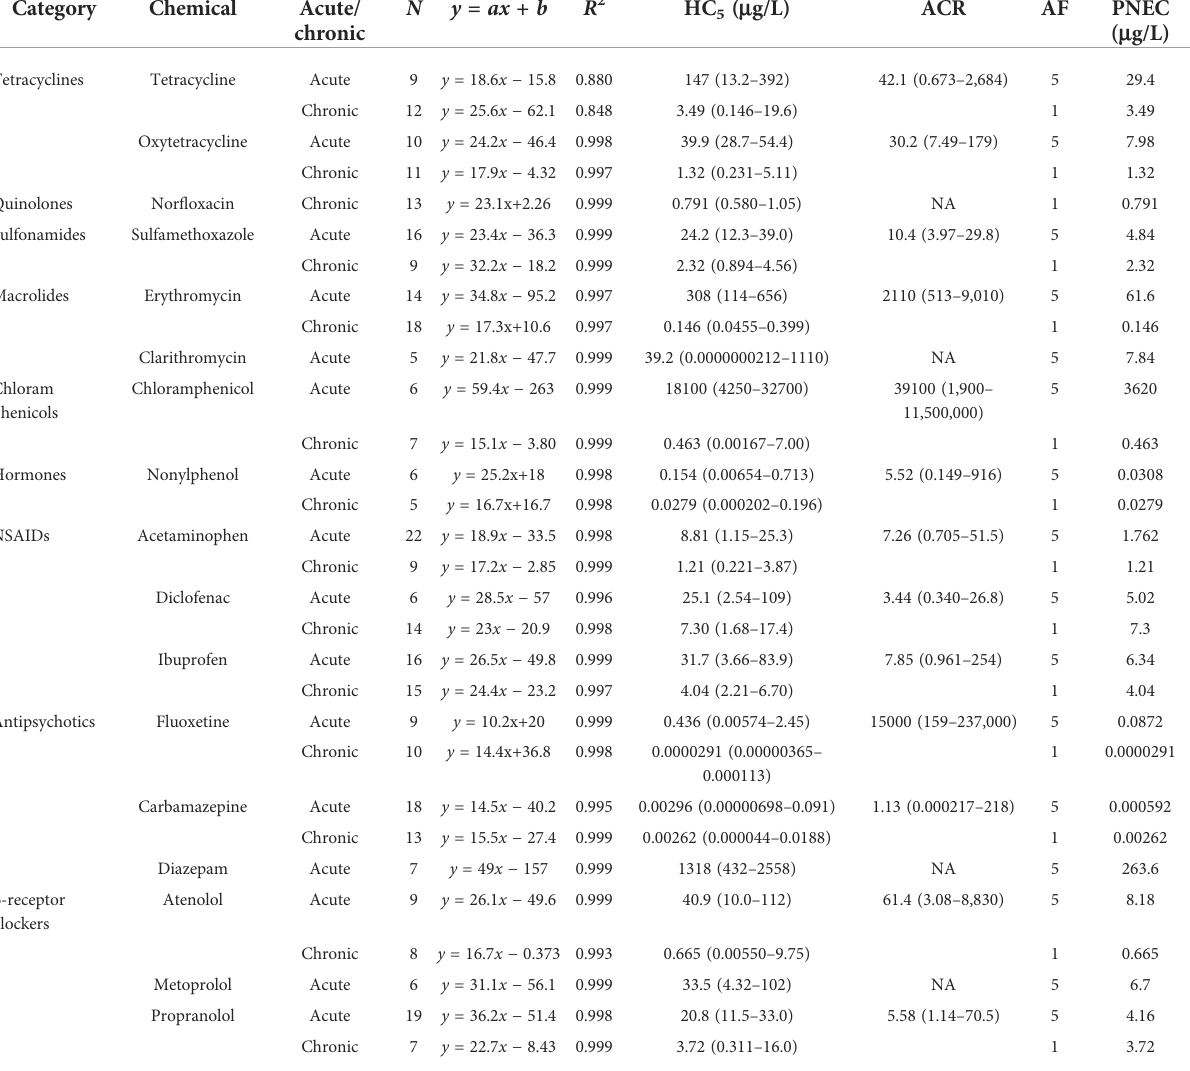
TABLE 1 Derived predicted no-effect concentrations (PNECs; in micrograms per liter) using species sensitivity distribution approaches and acute- to-chronic ratios (ACRs) extrapolated from corresponding acute and chronic 5% hazard concentration (HC 5 )